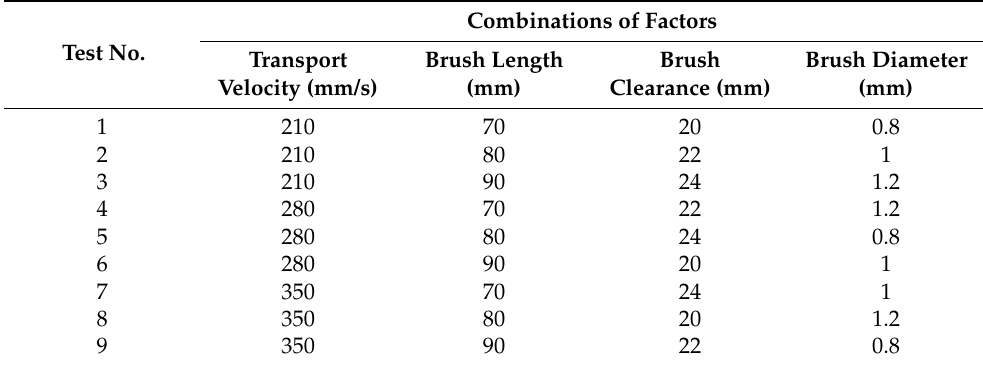
Table 3. Taguchi orthogonal array (L 9 (3 4 )) to analyze the effect of change in control factors.